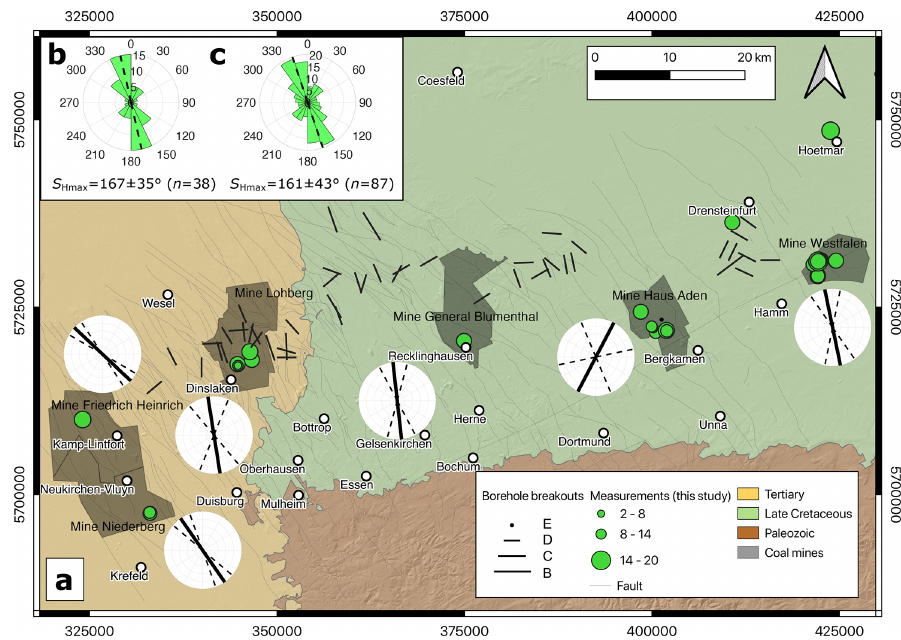
Figure 7. (a) A map of the greater Ruhr region with major geological discontinuities (modified after GD NRW, 2017, 2019) and locations of stress magnitude data records described in this study. Black shaded areas represent coal mining areas active in 1980s. Polar plots represent average S Hmax orientations (solid line) and its standard deviation (dashed line) registered in each coal mine (black thick lines show the orientation of the maximum horizontal stress, S Hmax , available in the World Stress Map database (Heidbach et al., 2018), where line length is proportional to data quality). (b) Rose plot of S Hmax orientations based on hydrofracturing tests collected in this study ( n = 38) with D- and E-qualities where average S Hmax orientation (dashed line) amounted to 167 ± 35 ◦ . (c) Rose plot of S Hmax orientation data records based on this study and data points from the greater Ruhr region available in the World Stress Map database release from 2016 (Heidbach et al., 2018), with B- to E-qualities, with an average S Hmax orientation (dashed line) of 161 ± 43 ◦ ( n =